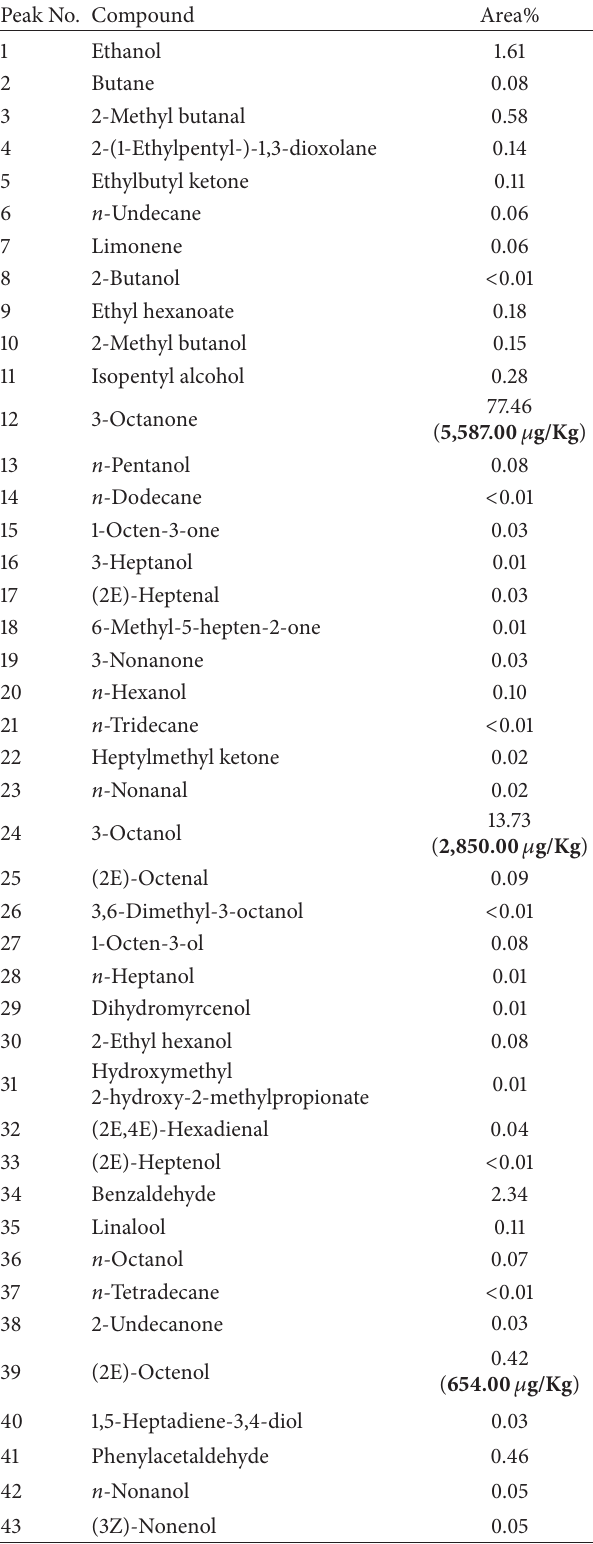
Table 2: Flavor volatiles in fresh samples of A. bisporus expressed as relative FID peak areas. In parentheses, quantitative values obtained by the standard addition method. Compounds are listed according to the elution order on Supelcowax-10 (PEG)